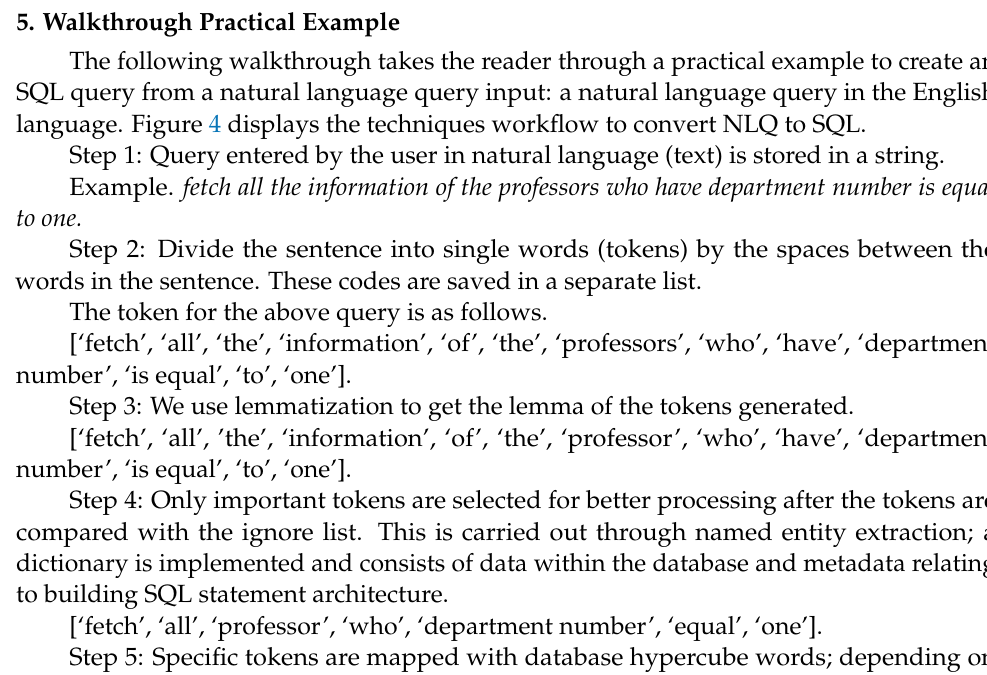
Figure 3. Model architecture.